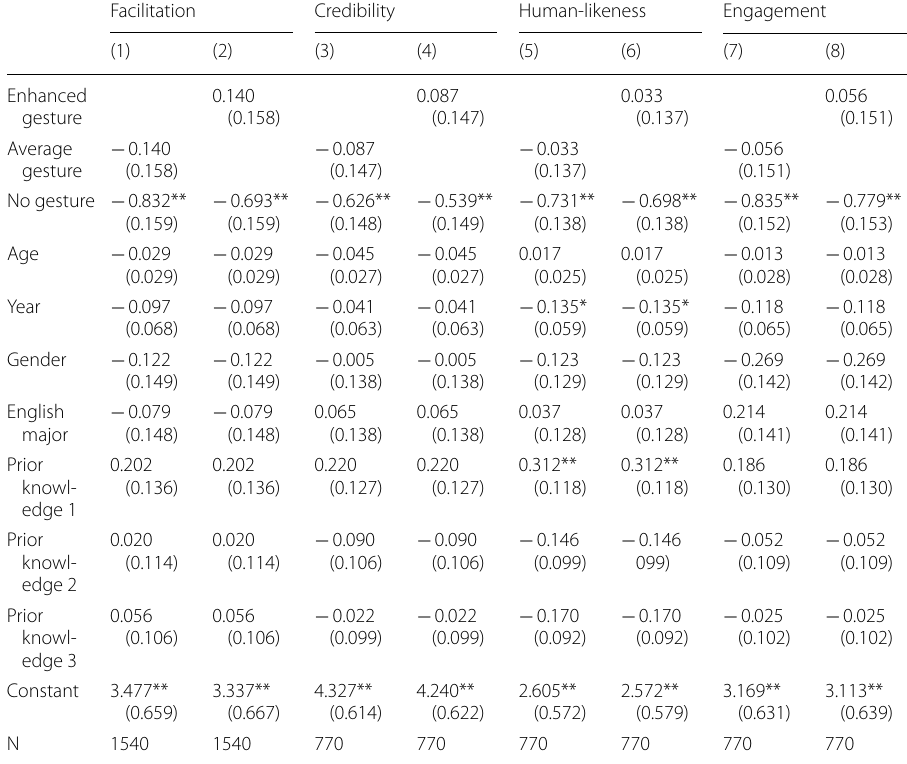
Table 2 Regression results for agent